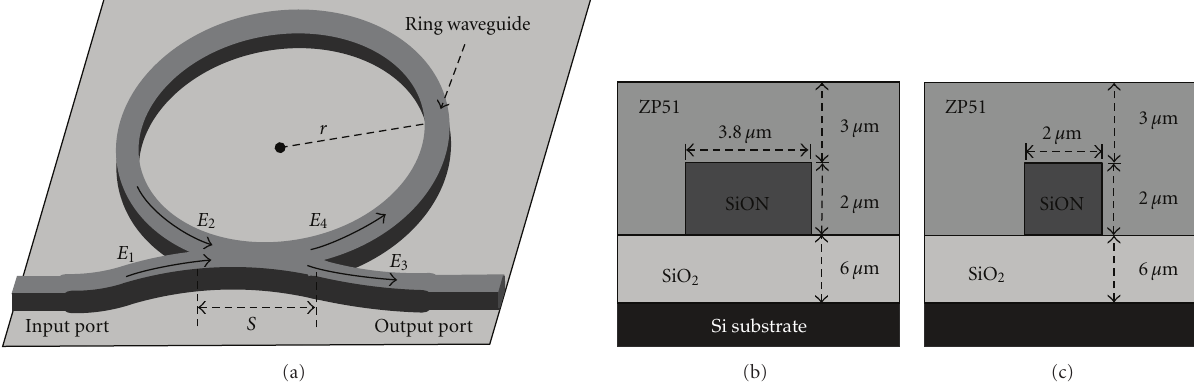
Figure 1: Schematic diagram of the SiON optical waveguide ring resonator (a), together with the materials and the dimensions of the two-mode waveguide (b) and the single waveguide (c) used in the fabrication work.